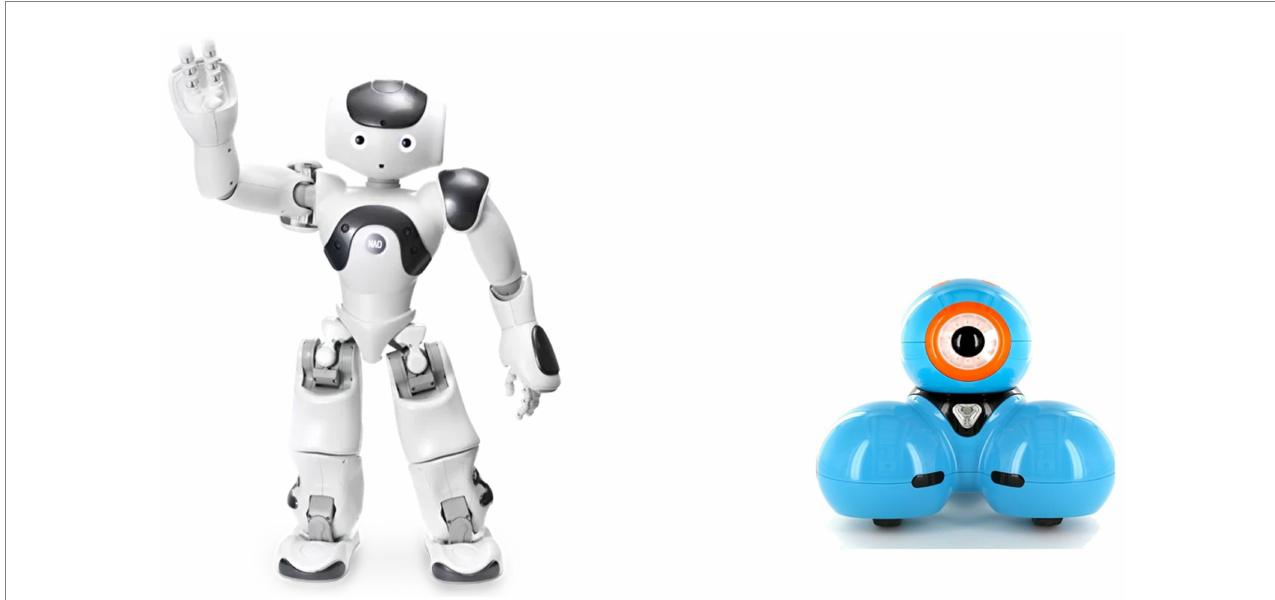
FIGURE 1 The humanoid robot Nao (left) and the non-humanoid robot Dash. The humanoid robot Nao (left) [reproduced with the permission of Aldebaran; NAO (c) Aldebaran, part of United Robotics Group] and the non-humanoid robot Dash (right) [reproduced with the permission of Wonder Workshop].